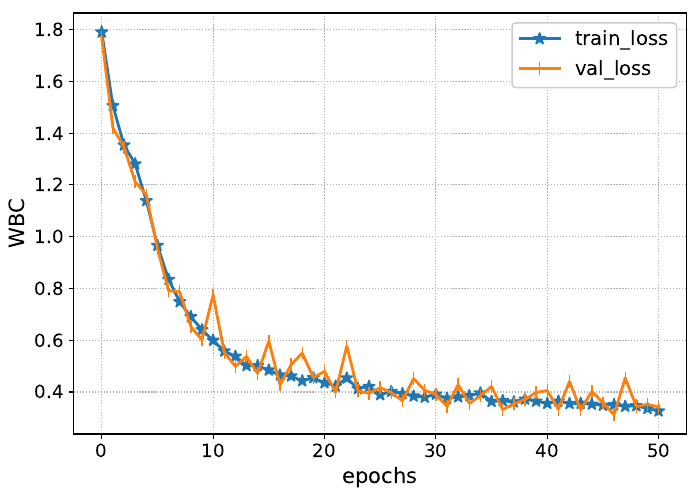
Figure 5. Loss analysis of Inception-V4 during